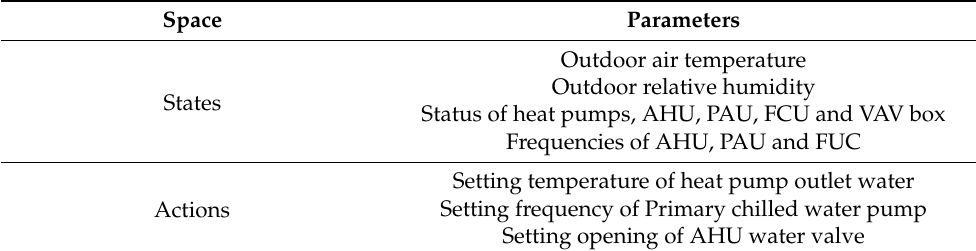
Table 2. State space for the implemented RL algorithm.